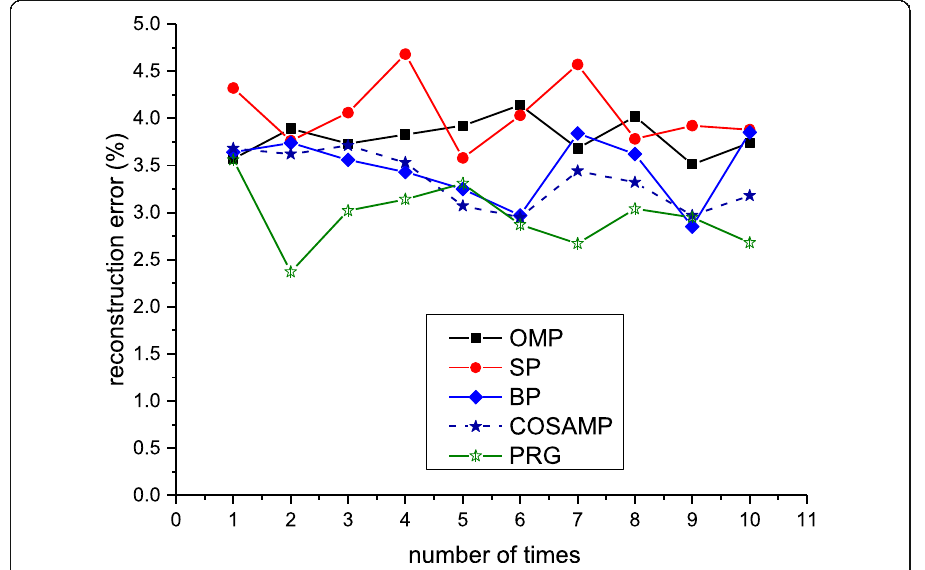
Fig. 7 Temperature sensing reconstruction error based on compressed